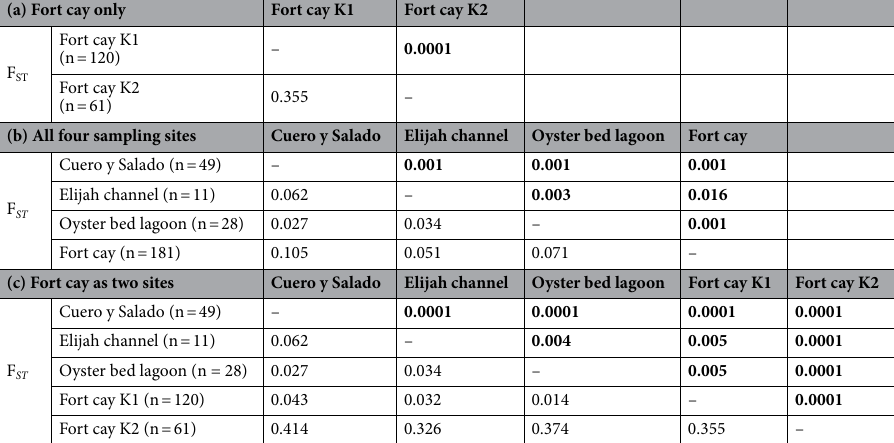
Table 1. Pairwise F ST of Honduran Rhizophora mangle stands. Significance values are in bold. F ST values are in the lower quartile and significance values (using AMOVA tests) in the upper quartile of each table. Number of samples per site on which the analyses were undertaken (n) are in parentheses after the site